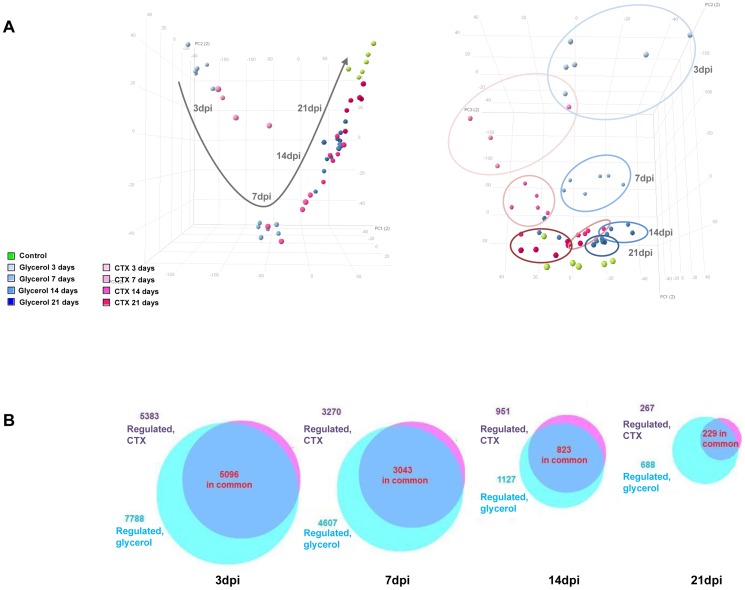
Overview of transcriptomic analysis showing time-dependent genome wide regulation.(A) Principal component analysis diagram showing most variation between time points along the first principal component axis (left graph), and differentiating between models along the third principal component axis (right graph). (B) Venn diagrams comparing the number of regulated genes in the glycerol and CTX models vs. control at 3 dpi, 7 dpi, 14 dpi and 21 dpi time points. Gene expression changes were considered significant when the absolute Fold Change >2 and adjusted p-value <0.01.